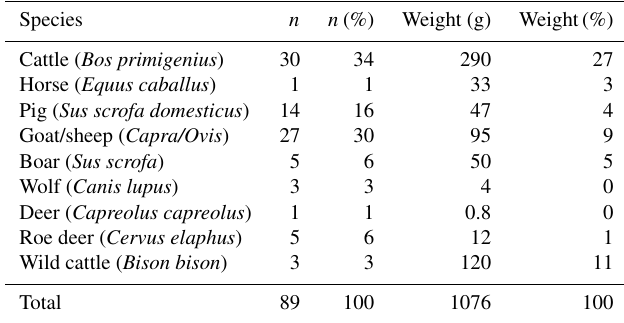
Table 3. Absolute ( n ) and relative number ( n in %) of animal bones and absolute (g) and relative weight (mass in %) of species-specific animal bones which were assigned to their